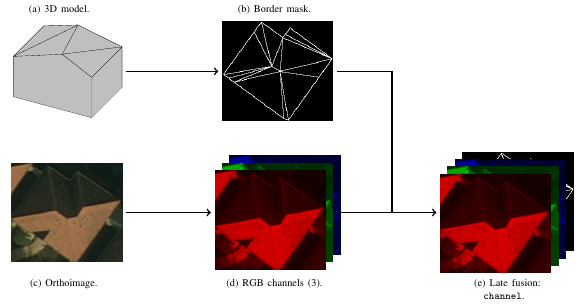
Figure 3. Early fusion scheme ( deletion ). Pixels that coincide with the 3D model border mask are assigned the zero value.